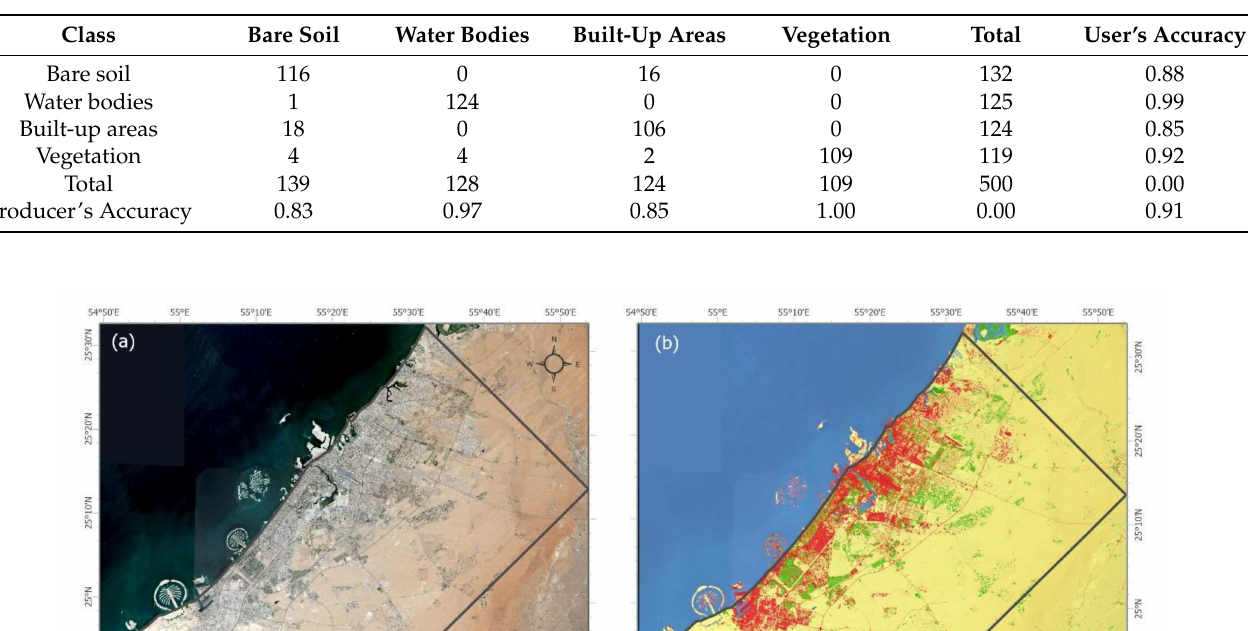
Table 1. Confusion matrix of the utilized GEOBIA classification approach.